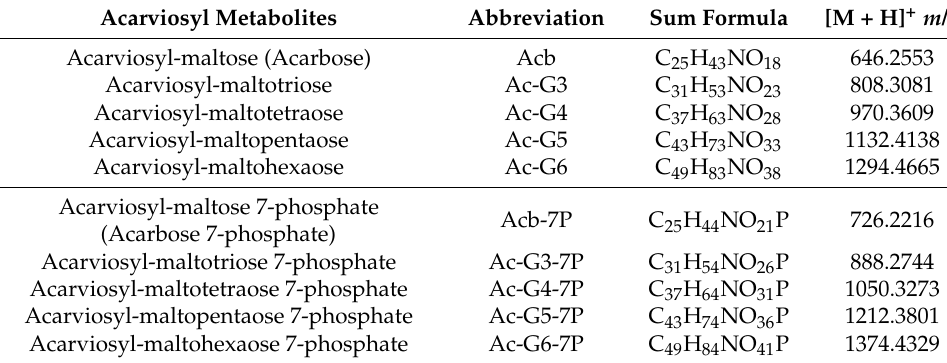
Table 2. Overview of acarviosyl metabolites derived from acarbose. Mass list of phosphorylated